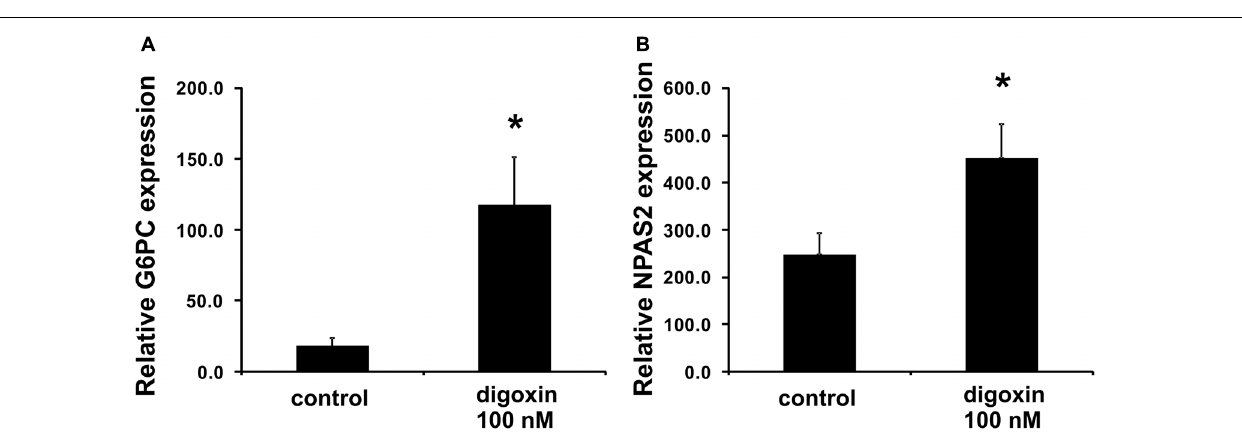
FIGURE 4 | Effect of digoxin on the expression of ROR γ -dependent genes in HepG2 cells. HepG2 cells were treated with digoxin (100 nM) for 24 h and then collected for RNA extraction. The expression of the (A) G6PC and (B) NPAS2 genes was determined by real-time RT-PCR and normalized to the housekeeping genes HPRT1 , HMBS , and RPL13A . Mean ± SD, n = 3, ∗ statistically significant difference at p < 0.05 compared with control